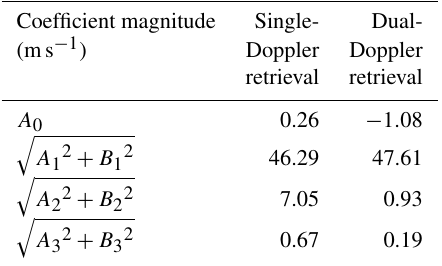
Table 4. V d D/R T harmonics coefficients’ amplitude (harmonics 0 to 3) retrieved from the single-Doppler and dual-Doppler analyses. Coefficient magnitude Single- Dual- (ms − 1